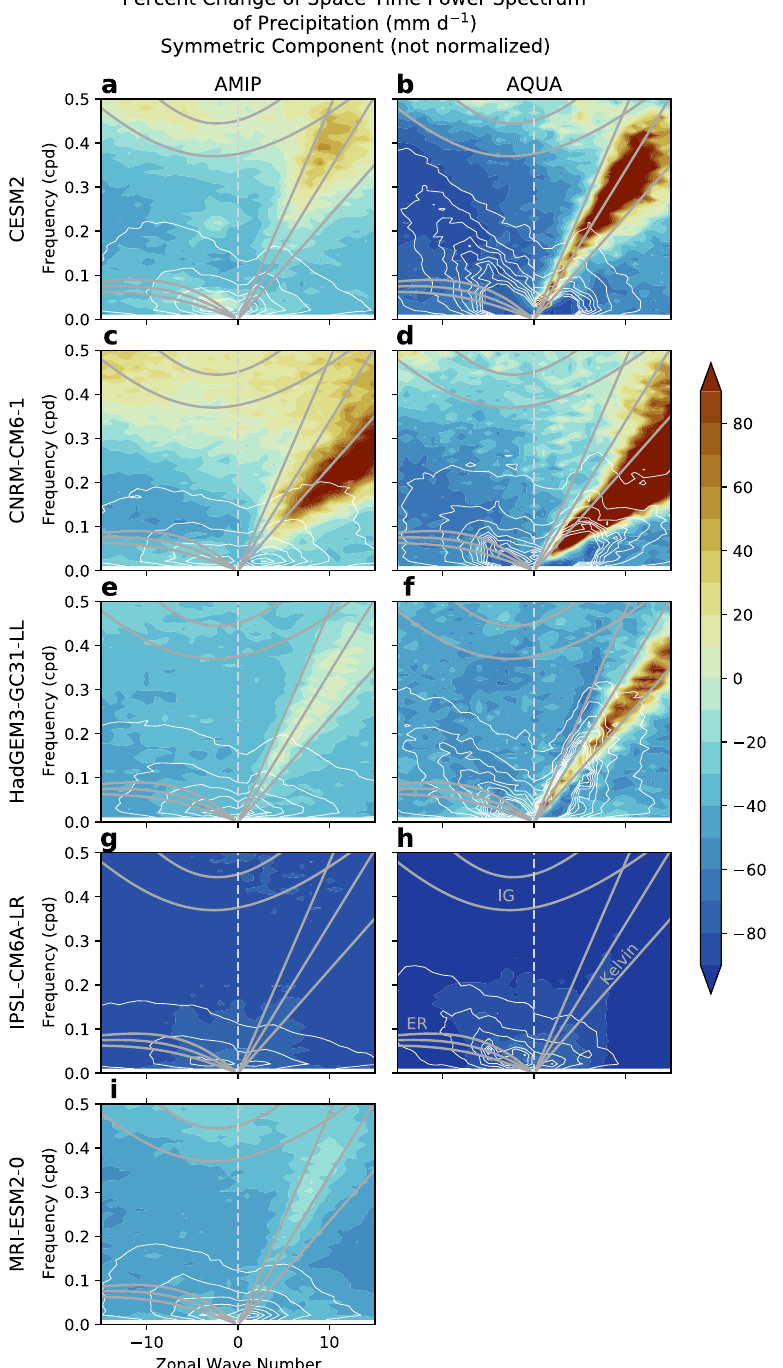
Fig. 5 Changes in wavenumber-frequency power spectra with LWoff. Color shading in each panel shows the percent difference, expressed as 100 × (LWoff − control)/control, of the non-normalized zonal wavenumber-frequency power spectra for the precipitation component symmetric about the equator for each model simulation. White contours show the associated spectral power using log base-10 scaling from the associated control simulation as a reference (contour interval is 0.15 up to 1.2). Powers are summed over 15°S – 15°N. Thick gray lines indicate shallow water dispersion curves for equivalent depths of 12, 25, and 50 m, annotations in panel h indicate Kelvin, equatorial Rossby (ER), and inertial gravity (IG) While suggestive, the detected extreme events should be markers) tend to be slightly larger in LWoff simulations than in viewed with some skepticism. Using daily mean precipitation may control simulations; this also holds for the cloud-locking experi- obscure higher frequency structure, removing some short but ments. Only two experiments show a different response: the CESM2 intense storms and blurring multiple events over consecutive days aquaplanet and the MRI AMIP experiments. These are the same two into long-lasting events. Sensitivity tests of the detection and experiments that show an increase in the number of events.